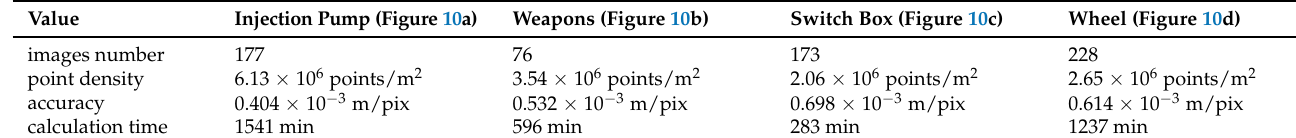
Table 2. Parameter of the reconstructed photogrammetry models.